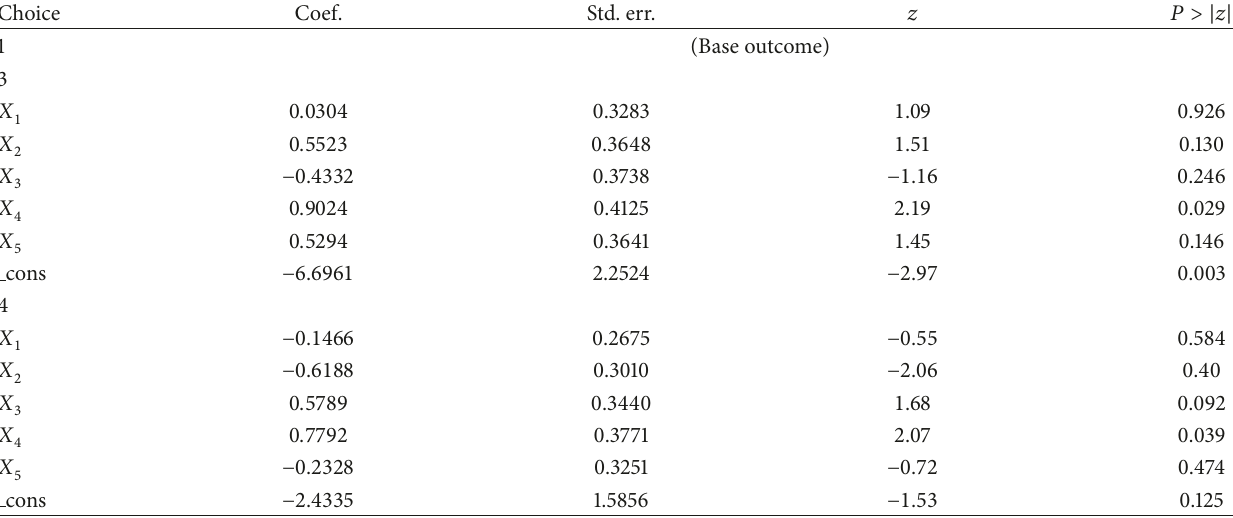
Table 5: Parameter calibration of parking behavior selection models for emergency